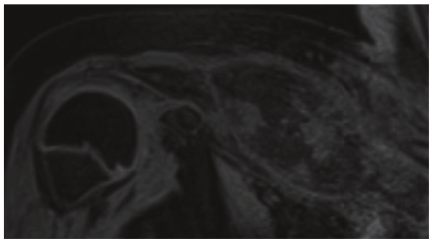
Figure 3: A large bony mass with heterogenous aspect and translu- cent areas.